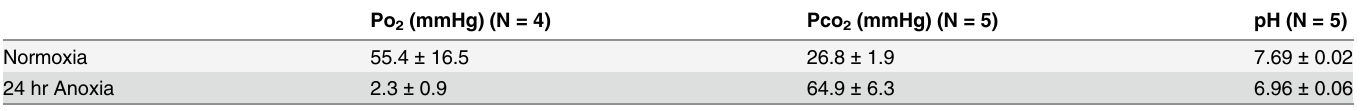
Table 1. Blood gases and acid-base status of normoxic and anoxic painted turtles at 19°C.